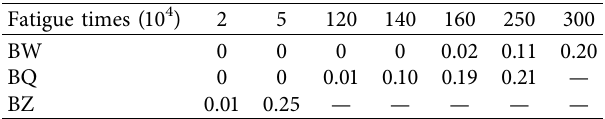
Table 8: Crack development of slab beams under the fatigue test